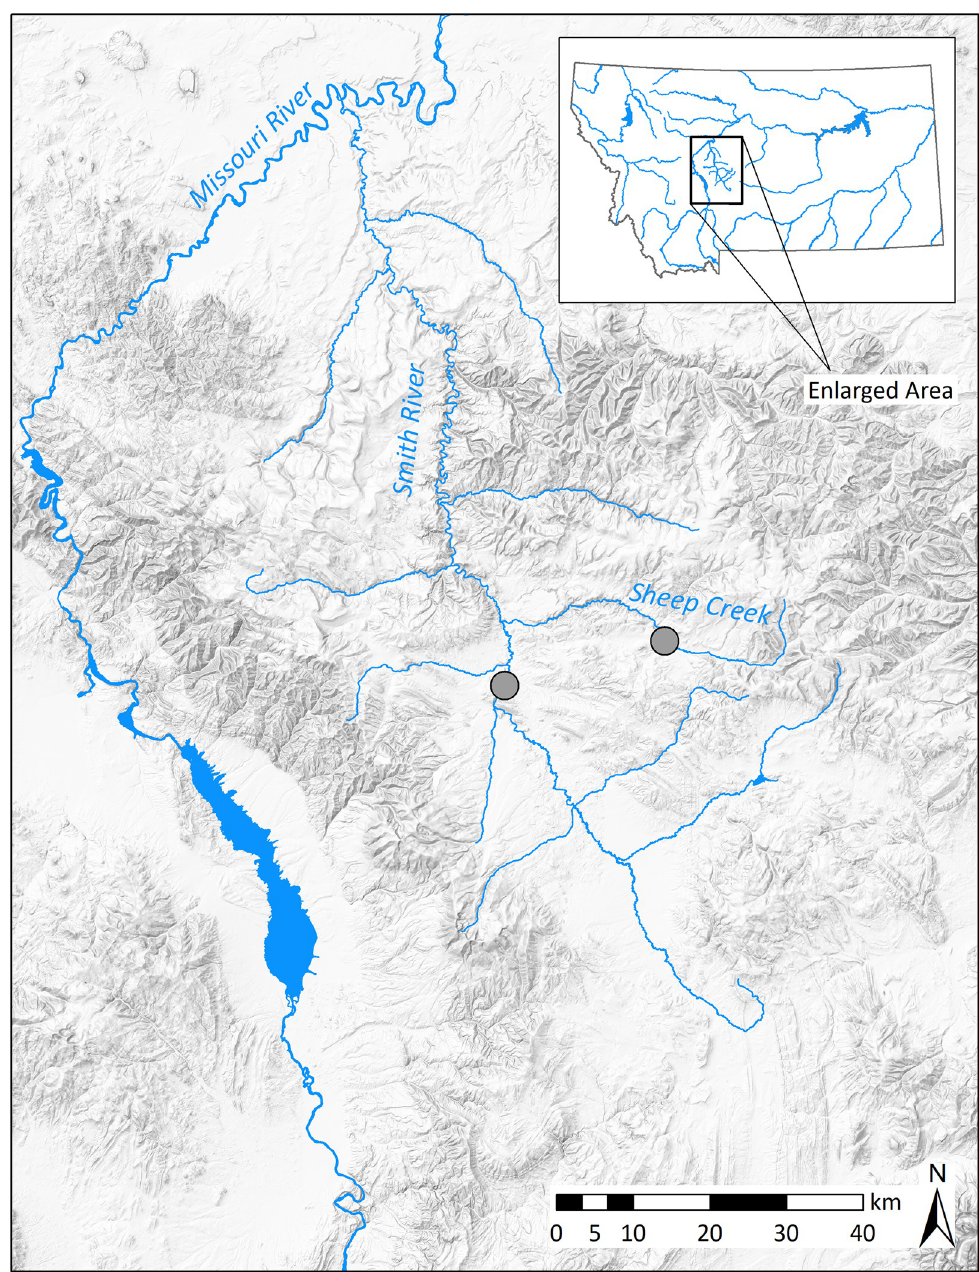
Fig 1. Study area map. The Smith River watershed in central Montana. Sampling reaches are denoted by grey circles. Graphic created using ESRI software (Redlands, CA) and open-access data from the Montana State Library including Montana Major Streams and Lakes (1993) and Grayscale Shaded Relief Image of Montana, 30-meter (2002). boom-anode configurations were both maneuvered to effectively cover the width of the stream being fished. Fish were anaesthetized using Aqui-S 20E (Aqui-S New Zealand Ltd.; 10 to 20 mg/L titrated to efficacy) prior to handling and were allowed to recover in fresh water prior to release. We measured the total length (TL) of each fish and collected diets using a standard gas- tric-lavage technique with a modified garden sprayer with an attached 6.35-mm polypropylene